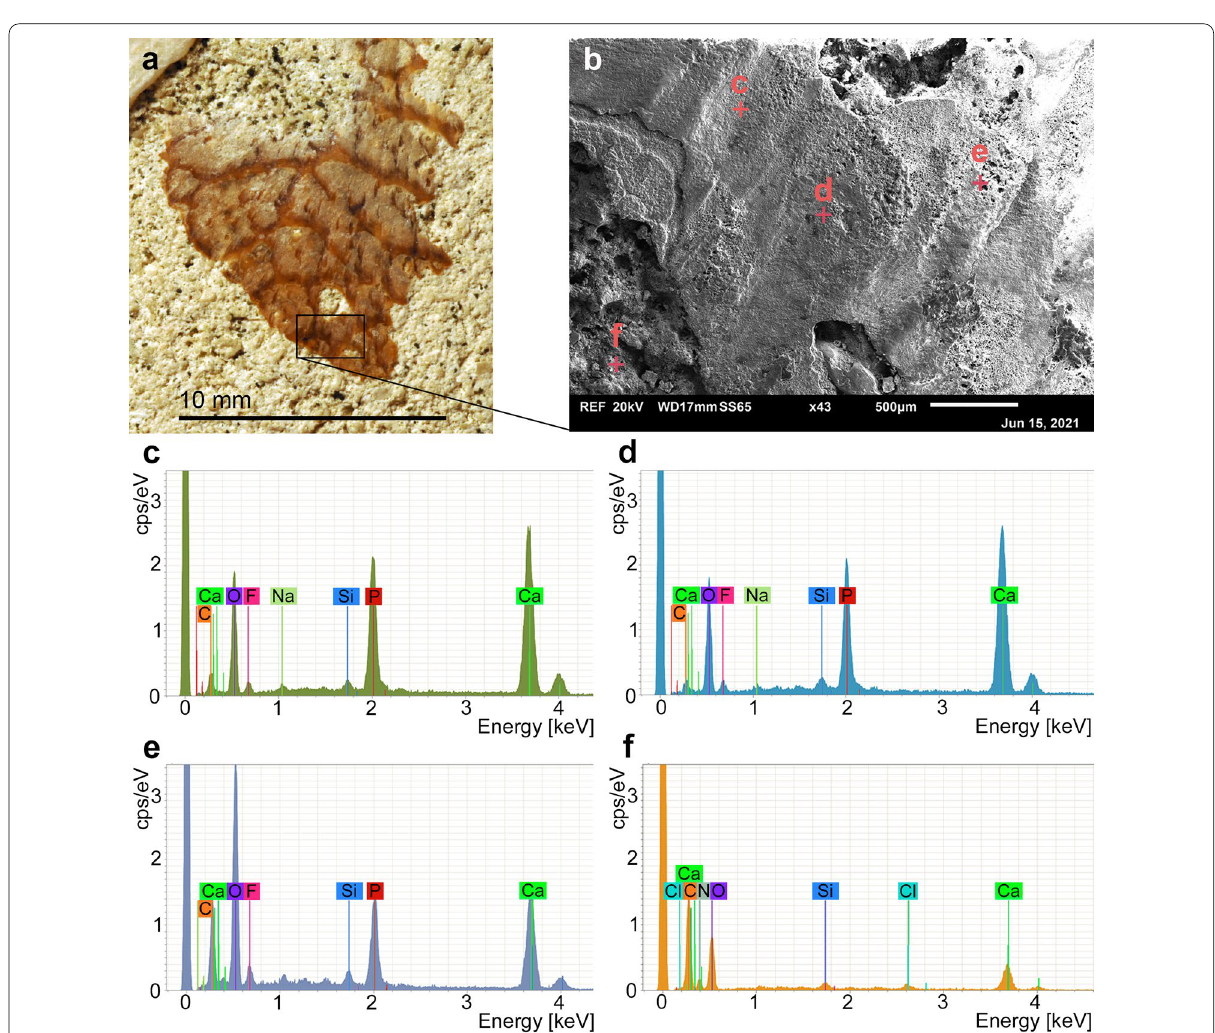
Fig. 3 Element analyses of the adductor remains and the sedimentary filling of the bivalve shown in Fig. 2. For the weight percent values, see Table 2. a Detail of the bivalve showing the part that was measured (black rectangle). b Magnified detail taken by SEM, showing the spots, where the EDX-measurements were taken. c and d EDX measurements from the beige parts. e EDX measurement from the brown parts. f EDX measurement from the internal mould (glauconitic